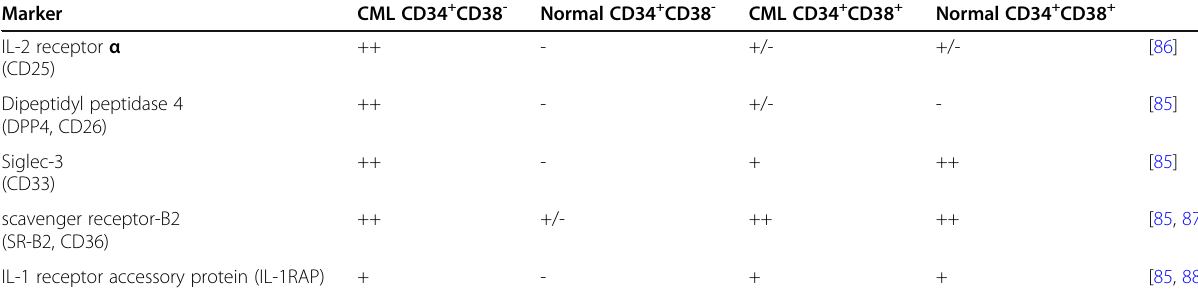
Table 2 Expression pattern of surface markers on normal and CML CD34 + CD38 - and CD34 + CD38 + cell populations Marker